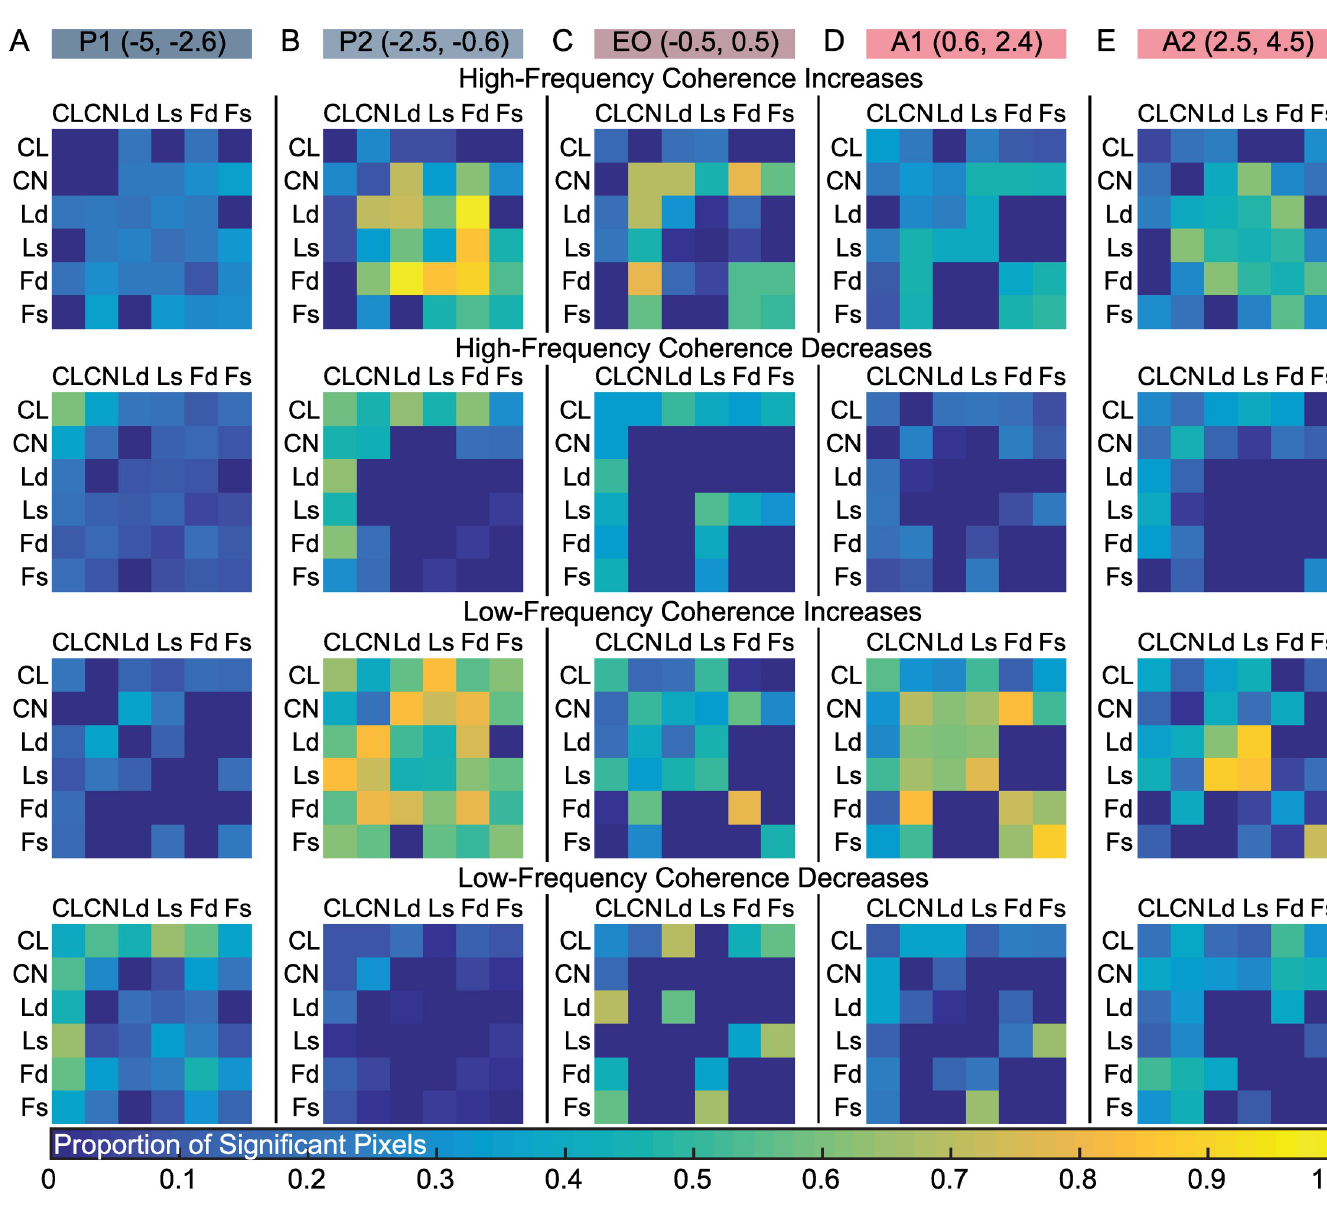
Fig 12. Pathways involving thalamus and striatum dominate the changes in coherence attributed to VPC. A - E , For each pairwise comparison across all areas, proportion of significant pixels indicating coherence increases/decreases at higher-frequency ( β , γ L , γ H ) or increases/decreases at lower-frequency ( δ , θ , α ) in time windows that ( A ) predate significant decoding and changes in consciousness (Pre 1, P1), ( B ) coincide with increased decoding and the start of changes in consciousness (Pre 2, P2), ( C ) coincide with behavioral changes (event onset, EO), ( D ) coincide with sustained changes in behavior and consciousness (After 1, A1), and ( E ) coincide with changed behavior but gradual restoration of consciousness as gauged with F � (After 2,